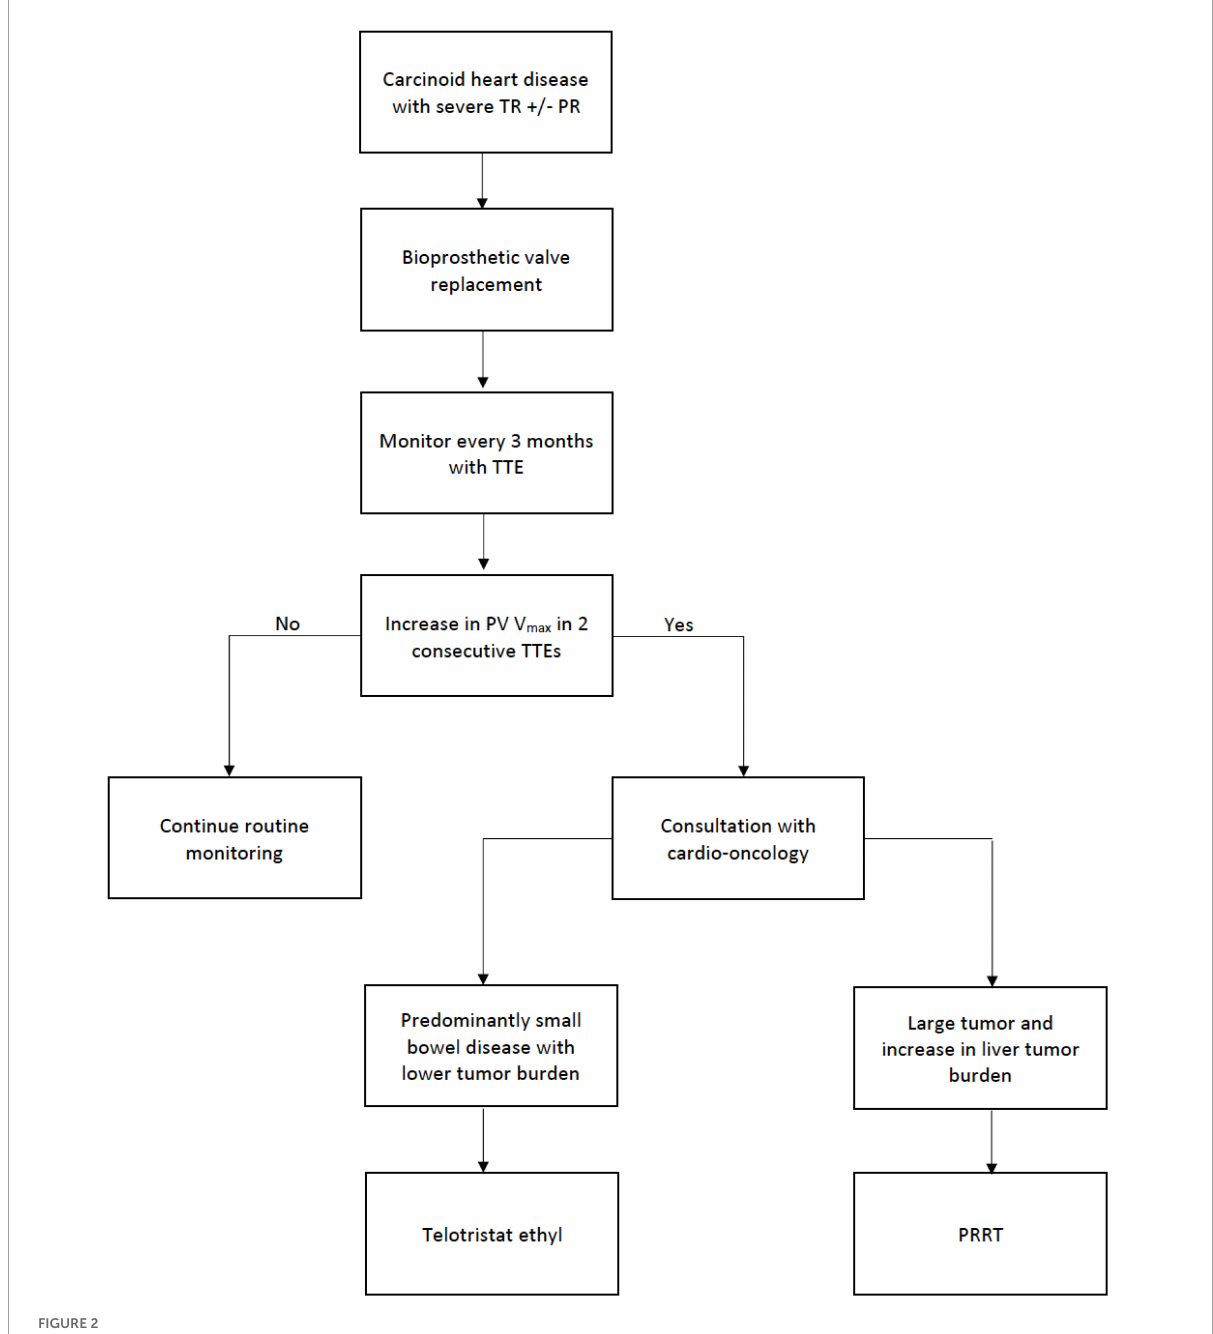
FIGURE2 Post-surgical treatment